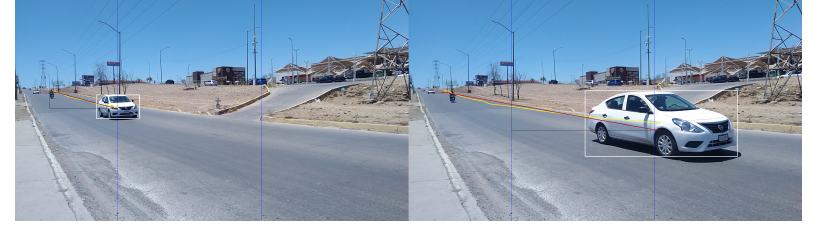
Figure 10. A valid sample.